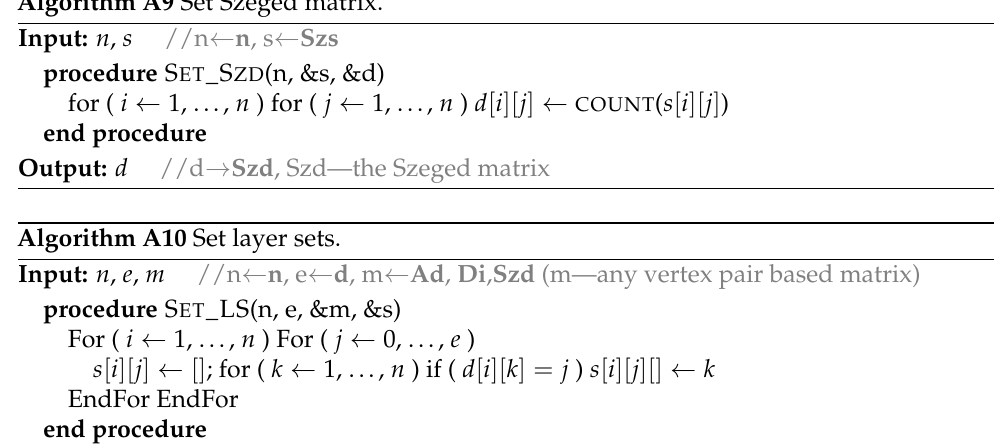
Algorithm A11 Set counting matrix.